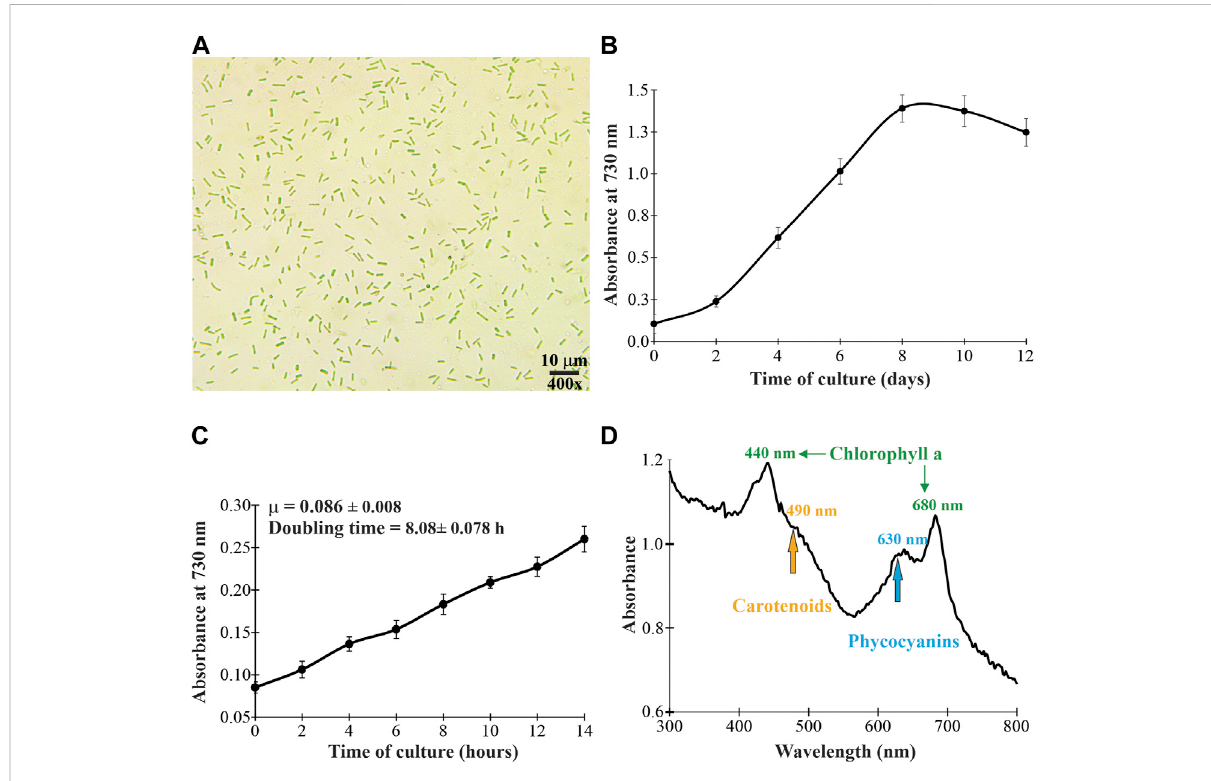
FIGURE 1 Microscopic morphology (A) , growth pro fi le (B) , speci fi c growth rate and doubling time (C) , and in vivo absorption spectrum (D) of the cyanobacterium Synechococcus sp. UCP002 isolated from the Peruvian Amazon Basin